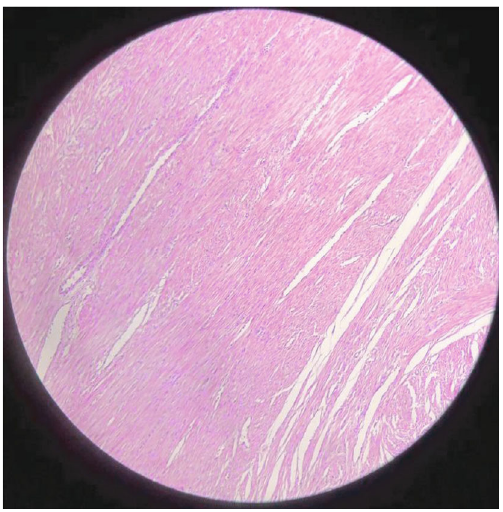
Figure 2: Pathology fi nding showed hemorrhagic leiomyoma with ulcerate and infected